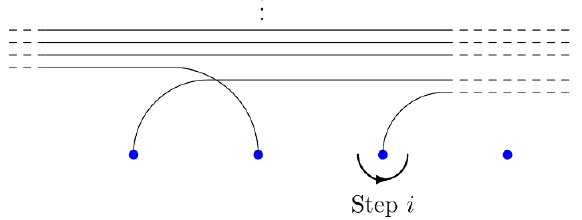
Figure 4 . Chord Diagram Recursions: A new line